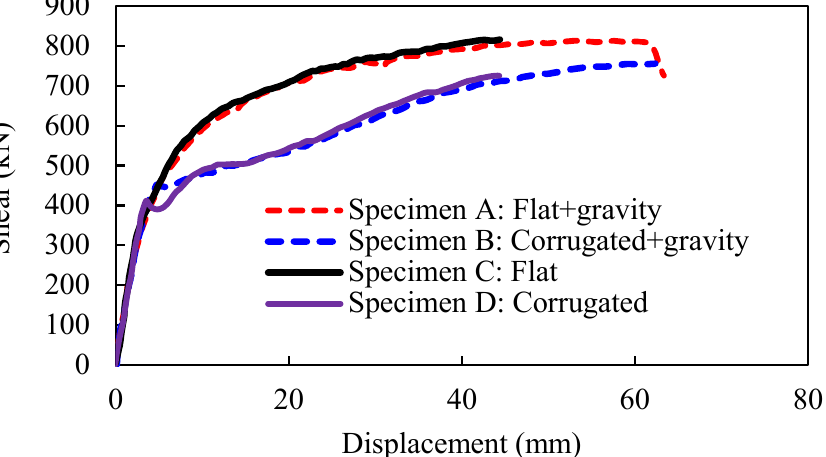
Table 3. Summary of test results.